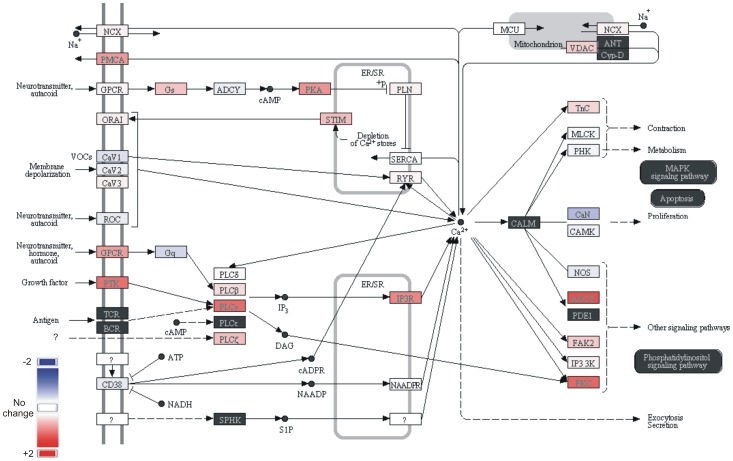
Calcium signaling network remodeling in aging porcine left atrium.Differentially expressed genes within a calcium signaling network in old versus young left atrium; network identified by pathway analysis (Ariadne). p = 0.009 for old versus young left atrial tissue with respect to the gene network shown (n = 3–5).